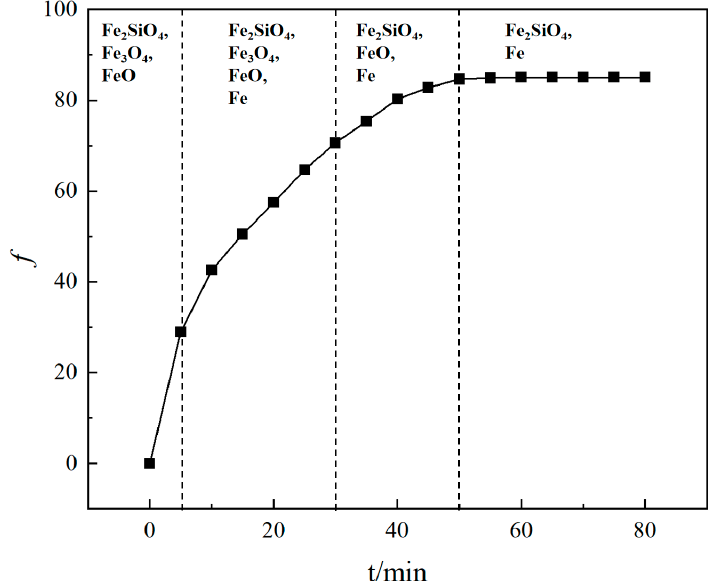
Figure 4. Experimental results under suitable conditions.